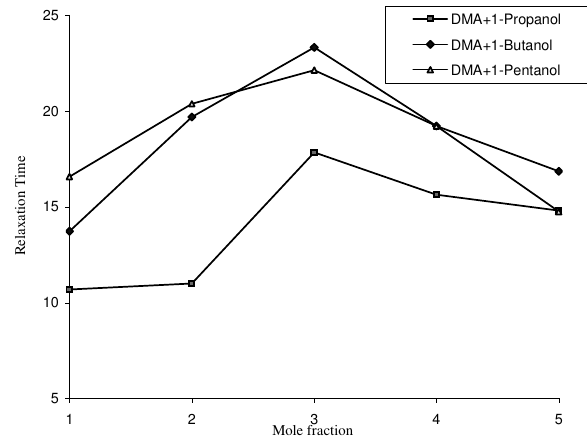
Figure 1. variation of dielectric relaxation time with